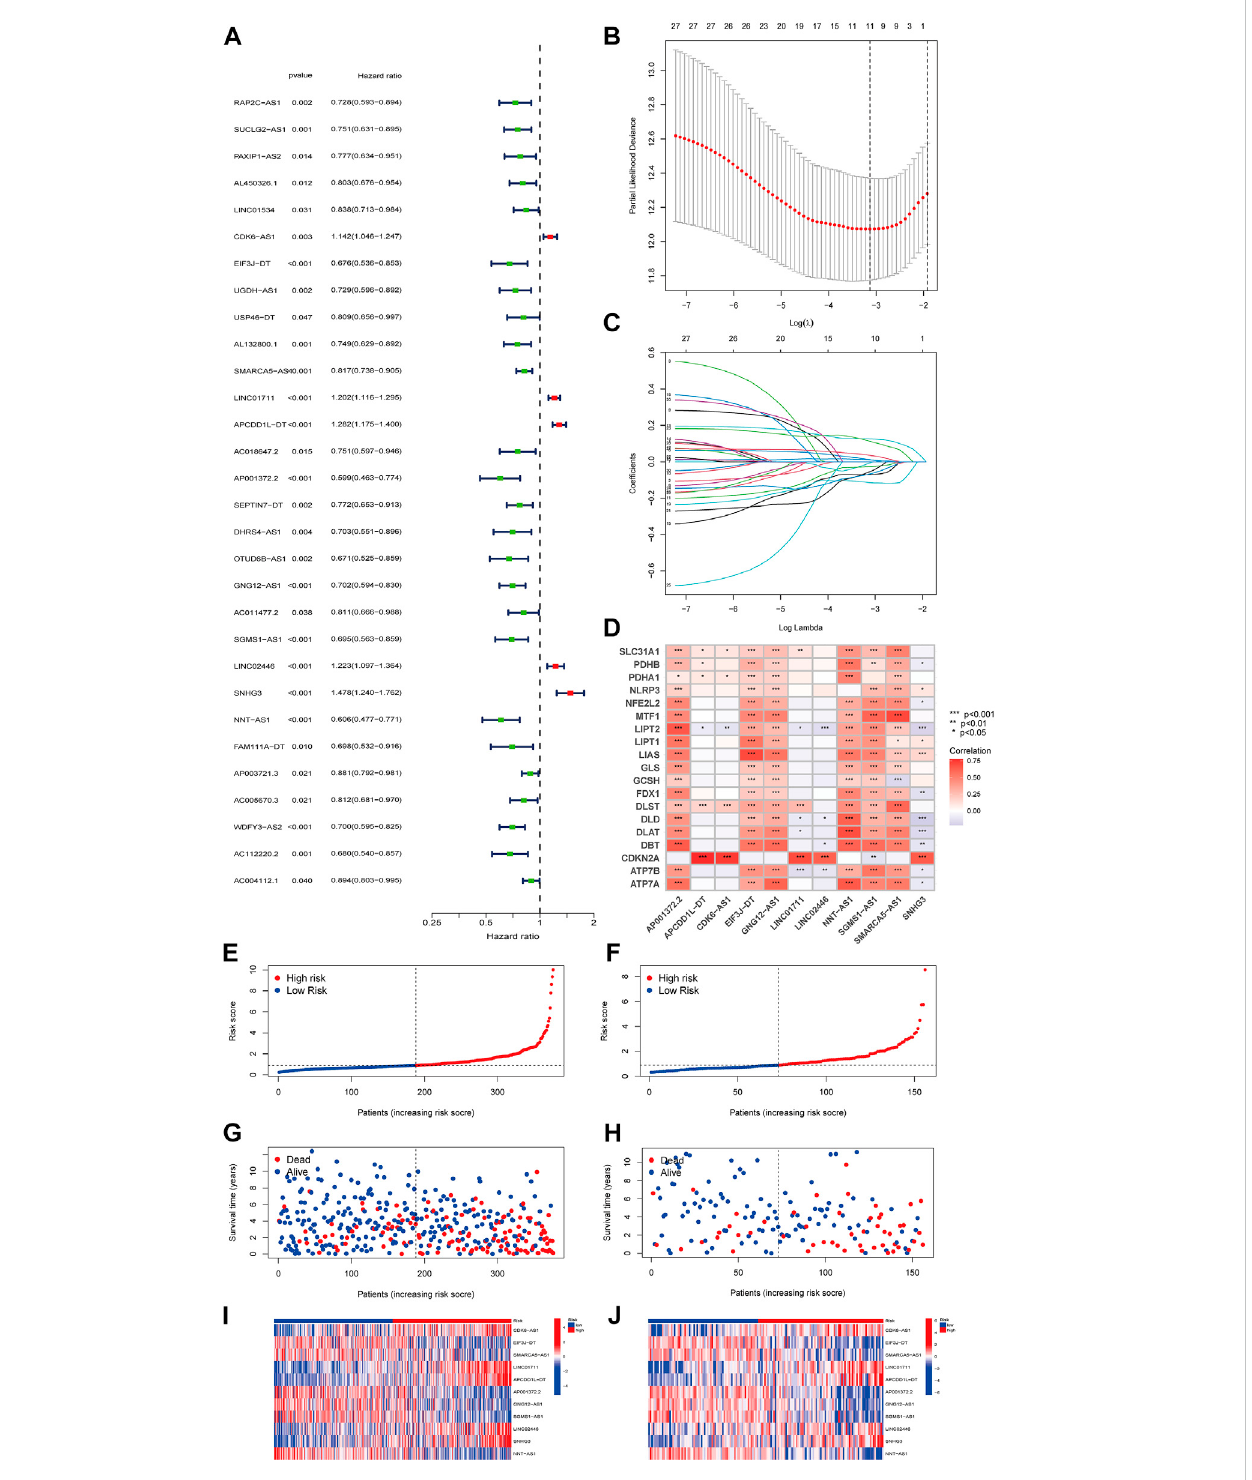
FIGURE 2 (A) Risk Forest Plot(redmeanshigh-risk lncRNA;greenmeanslow-risk lncRNA). (B) LASSOanalysisofcuproptosis-related lncRNAs. (C) Cross-validation for tuning parameter selection in LASSO regression. (D) the correlation between cuproptosis genes and the 11 prognostic cuproptosis-associated lncRNAs in theproposedsignature.Theabscissainthe fi gureislncRNA,ordinateiscuproptosisgene. (E,F) DistributionofriskscorestatusinpatientswithtrainccRCCand test ccRCC. (G,H) Scatterplot of survival status of patients with train ccRCC and test ccRCC. (I,J) Heat map of cuproptosis-related lncRNA expression pro fi les in train ccRCC and test